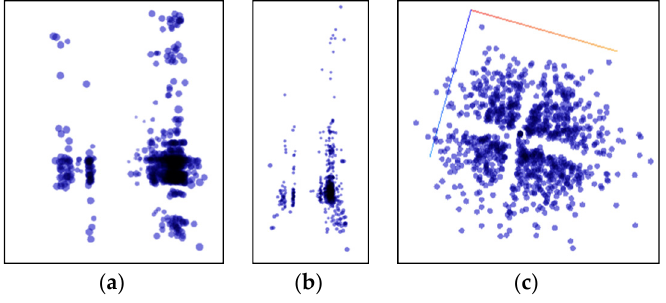
Figure 10. Use PCA to reduce the dimension to a 3D rendering. ( a ) x-y plane viewing angle; ( b ) y-z plane viewing angle.